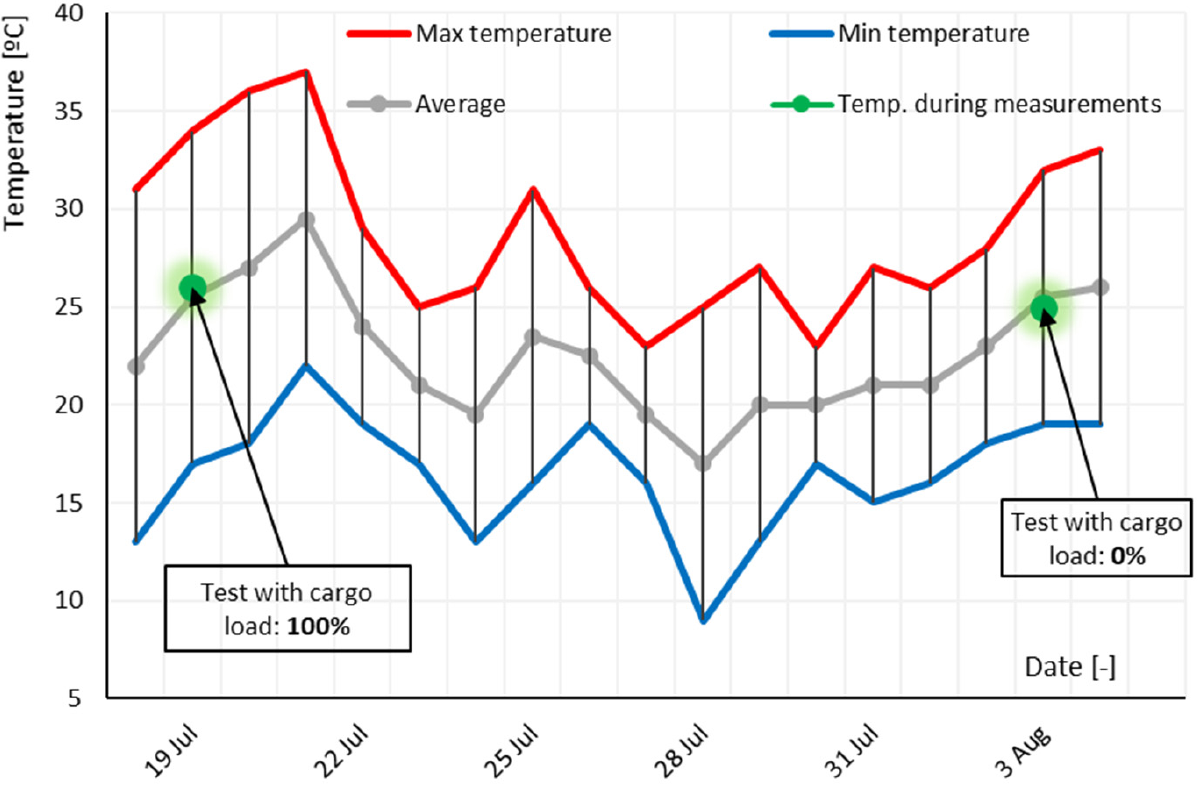
Figure 15. Ranges on measurement days [based on [34] and authors’ own Figure 15. R anges on measurement days [based on [34 ] a nd authors’ own measurements].